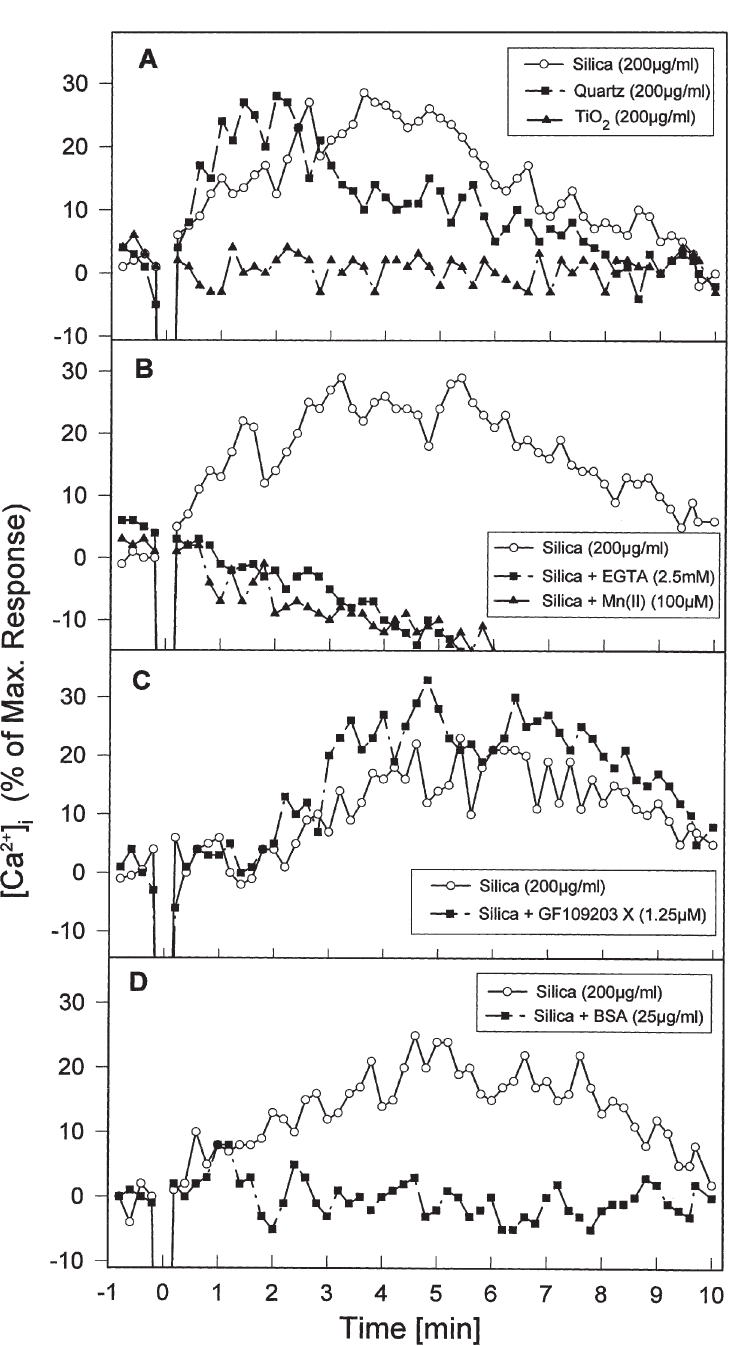
Fig. 2. Time course of [Ca 2 + ] i after stimulation of Fluo-3 stained BAM with dusts (200 µ g/ml). Cells were stimulated with quartz dust (Sikron F 600), silica powder (QUSO G 32) or TiO 2 (A), or silica powder with or without 10 min preincubation with 2.5 mM EGTA or 100 µ M MnCl 2 (B) or 1.25 µ M GF 109203 X (C). In (D) untreated silica or BSA-coated silica (final concentration of BSA 25 µ g/ml) were added. One representative measurement out of at least 6 similar experiments is shown as the percentage of maximum response. Stimulation procedure as in Fig.